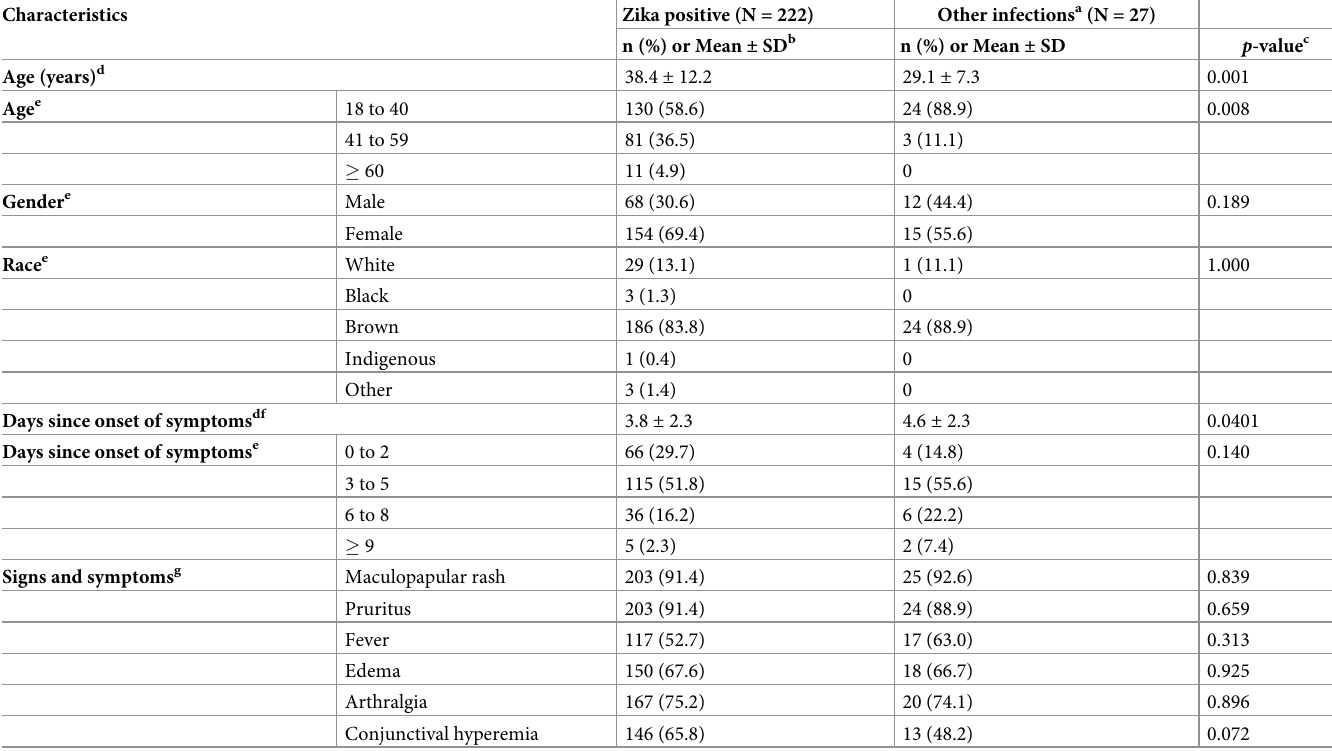
Table 2. Baseline and clinical characteristics of patients with Zika infection and other infectious causes of rash, FMT-HVD, Manaus, February 2018 to May 2019.